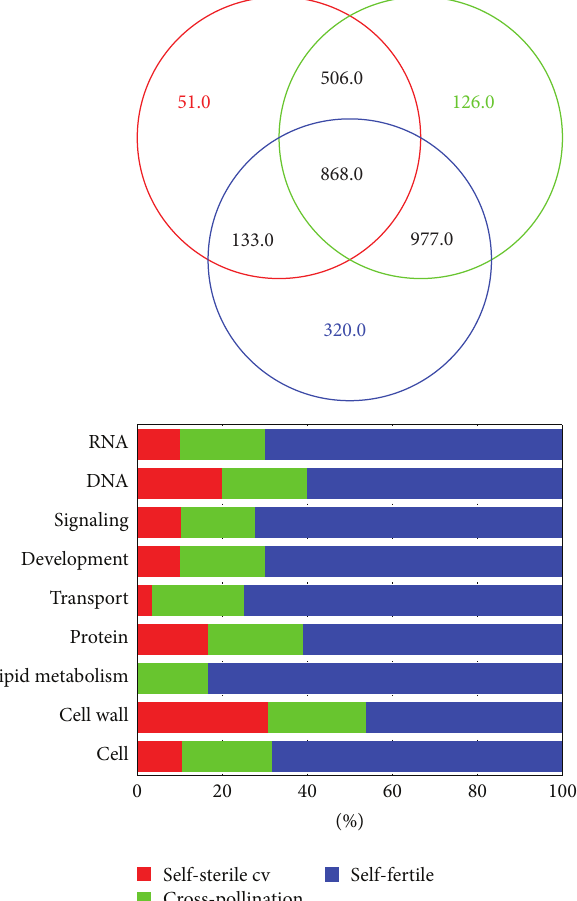
Figure 3: Venn diagrams and clustering of DE transcripts in their relationship with the analysed samples. For each sample, the categories most represented are displayed as stacked bar graph.